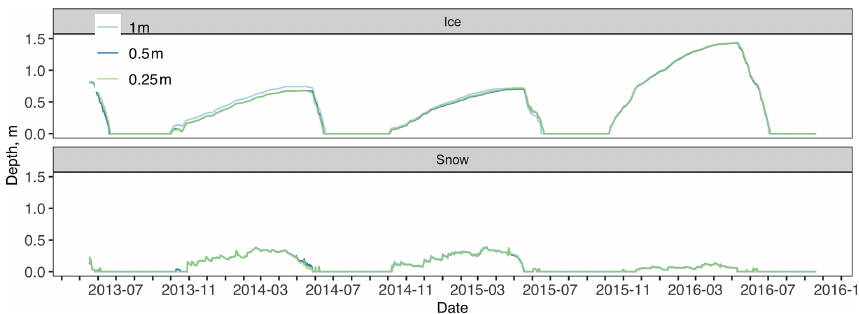
Figure D9. Toolik ice and snow depth across different water vertical resolution simulations. No observed data are available, 1m vertical resolution is in light blue, 0.5m vertical resolution is in blue, and 0.25m vertical resolution is in